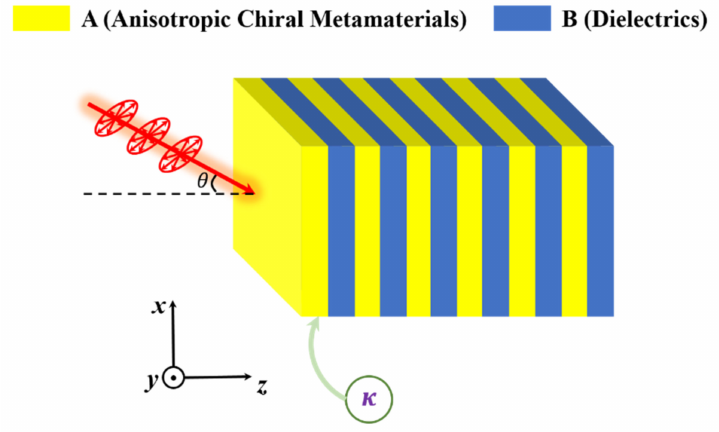
Figure 1. Schematic illustration of 1DPCs composed of ACMs and dielectrics. ( A ) and ( B ) represent an ACM and a dielectric,